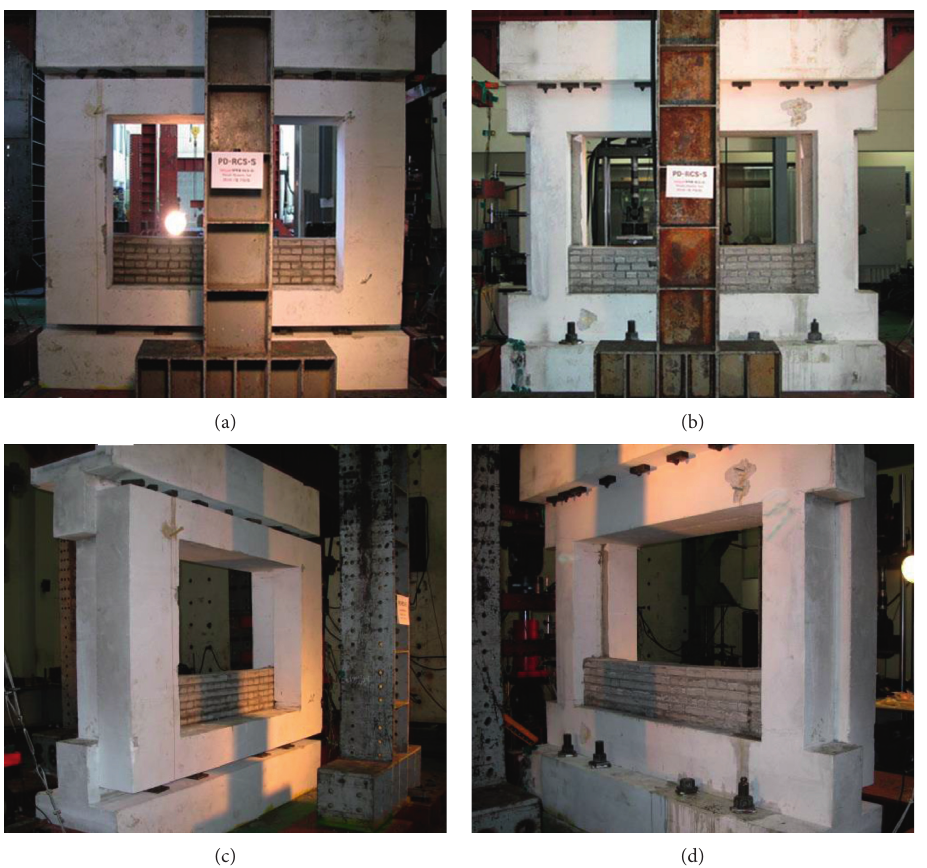
Figure 5: Detailed configuration of the test specimens strengthened with the ESRCF system. (a) Front view; (b) rear view; (c) front isometric view; and (d) rear isometric view.